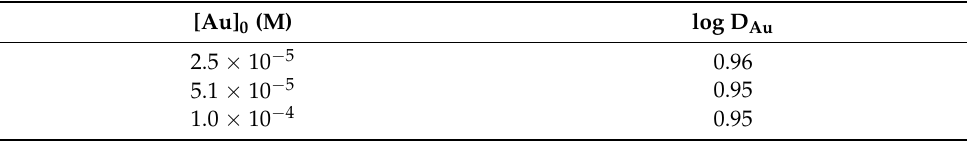
Table 2. Influence of the initial metal concentration on gold extraction.